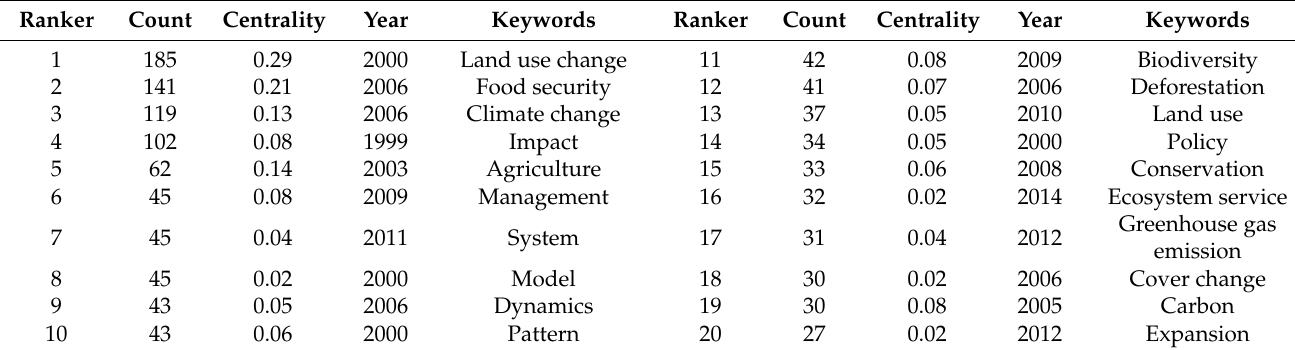
Table 4. Information table of top 20 keywords with